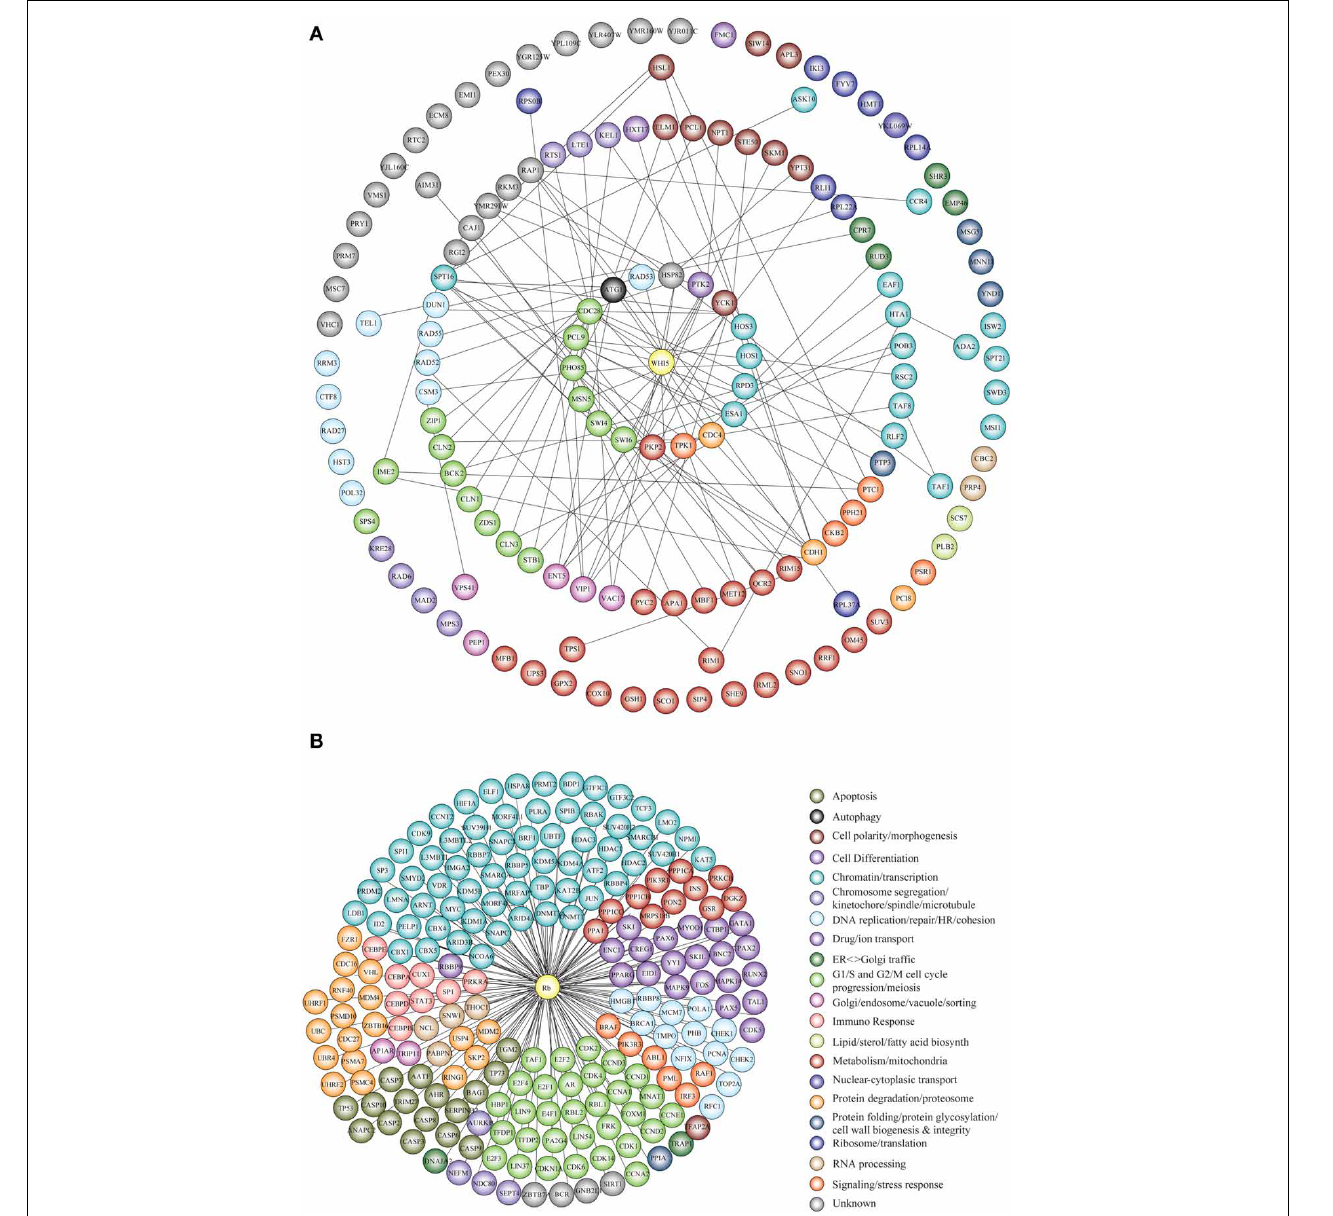
FIGURE 6 | Functional classification of Whi5 Sc and Rb interactors. (A) The interaction network of Whi5 Sc includes both physical and genetic interactors. Functional classification of interactors was derived from the classification model of Costanzo et al. (2004). The interaction network is hierarchical. The panel shows proteins physically binding to Whi5 Sc (inner circle, first level interactors), genetic interactors physically binding to first level interactors (second circle, second level interactors), genetic